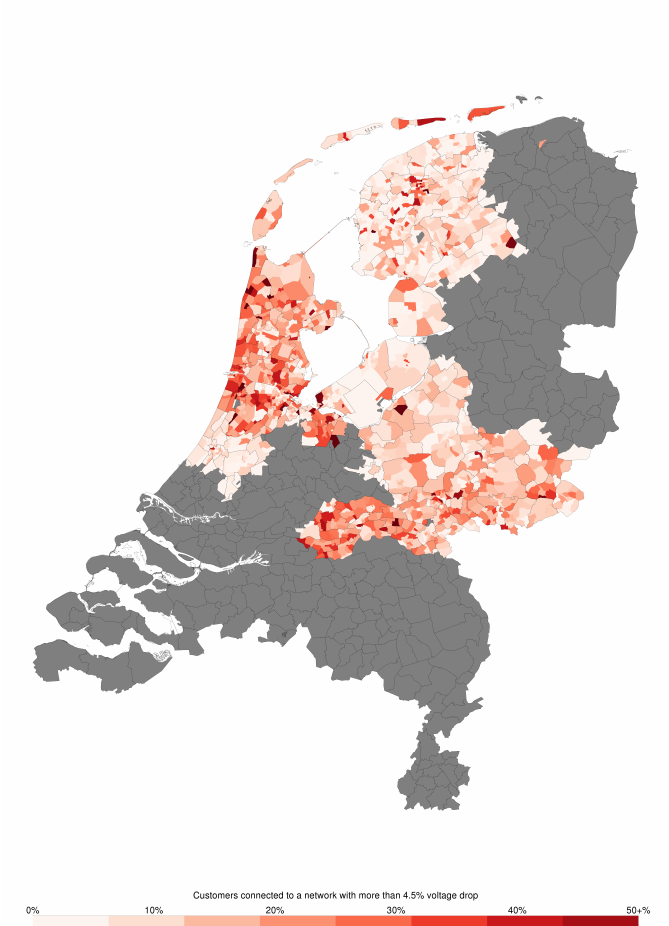
Figure 17. Geographic distribution of voltage problems in 2030 within 90% confidence. The gray area is The Netherlands in which Alliander operates the colored area. The total number of consumers with voltage problems in this figure is